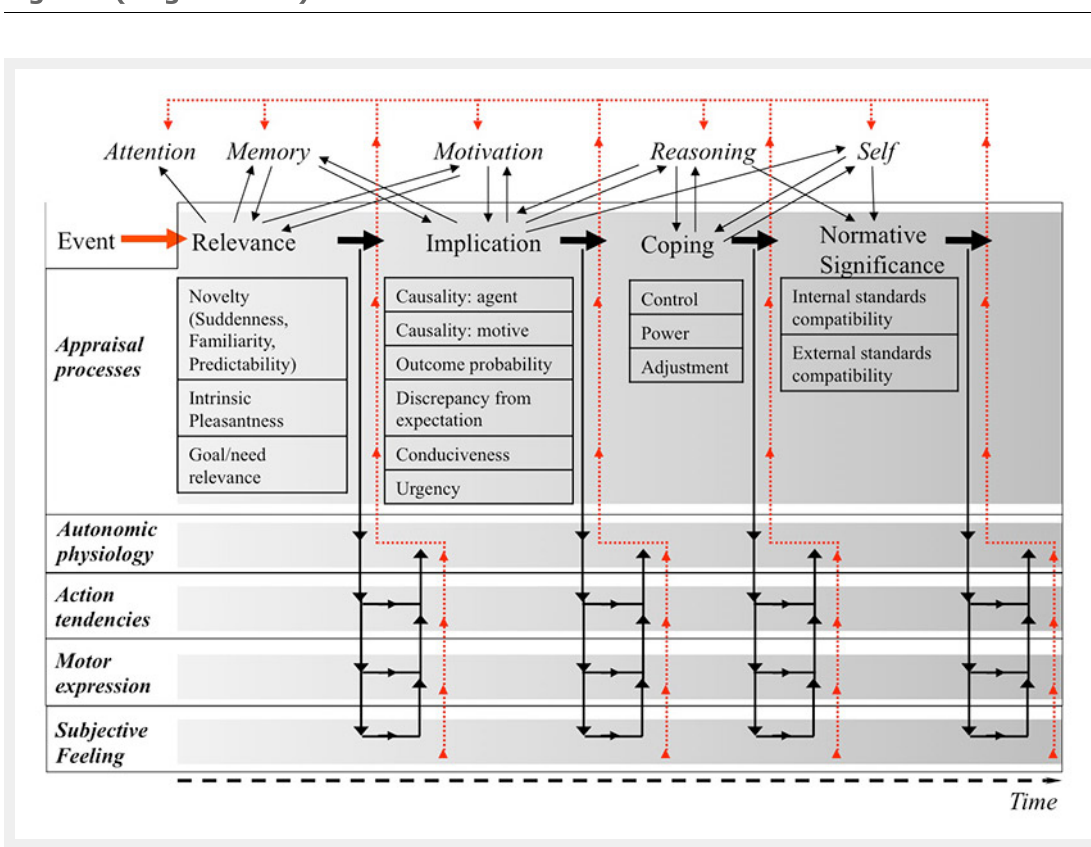
Comprehensive illustration of the Component Process Model. The model assumes that the appraisal process is organised in a sequence of four appraisal objectives. Each appraisal outcome leads to changes in the other emotion components (physiology, action tendency, motor expression, and subjective feeling, as illustrated by the descending arrows). The ongoing appraisal process furthermore interacts with other cognitive functions. For example, minimal attention needs to be given for appraisal to start, but a relevance outcome will immediately deploy further attention to the stimulus. The model thus allows a detailed consideration of the effects of emotional processes on attention, memory, and other cognitive processes (as illustrated by the arrows in the upper part of the figure). Finally, changes in the other emotion components may also influence cognitive functions (as illustrated by the red ascending arrows), for example by increased memory consolidation via increases in physiological arousal, which may in turn influence the processing of appraisal